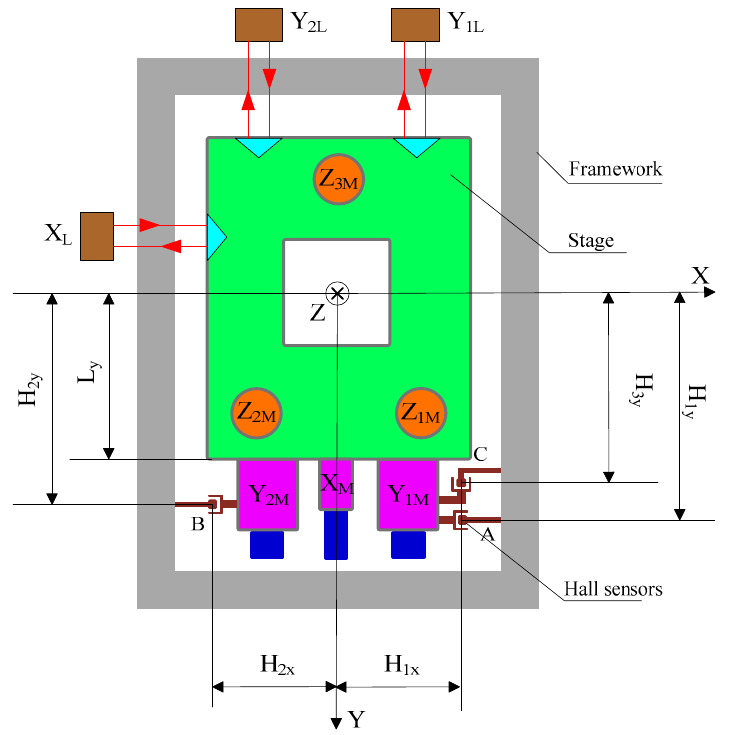
Figure 6. The dimension figure of the investigated stage.